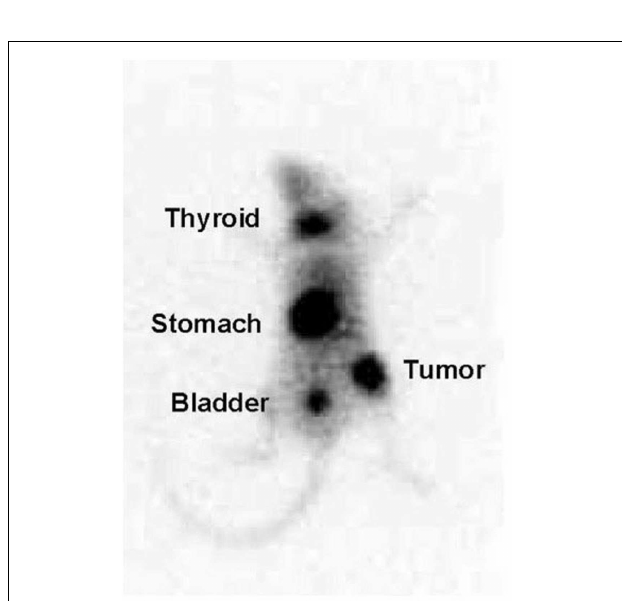
FIGURE 2 | 123 I scan of a mouse with the adenovirus-derived vector with a non-specific promoter (CMV) carrying the sodium-iodide symporter gene (NIS;Ad-CMV-NIS). The infected prostate cancer xenograft over right hip shows radioiodine uptake while there is no uptake over the control tumor on the left